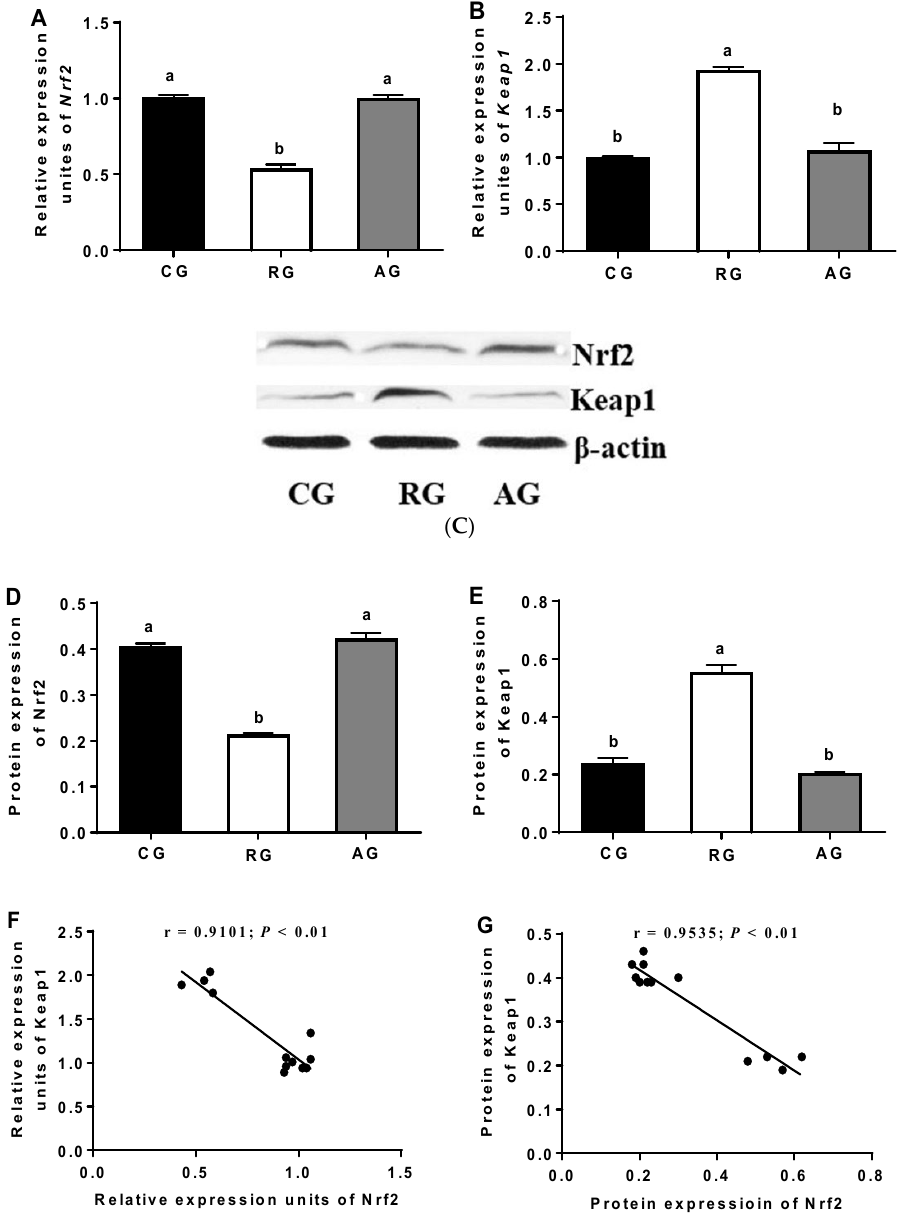
Figure 4. Effects of diet and arginine on Nrf2/Keap1 pathway in ovaries of ewes. ( A ): Relative expression units of Nrf2; ( B ): Relative expression units of Keap1; ( C ): The protein expressions of Nrf2 and Keap1 were determined by western blot; ( D ): Protein expression of Nrf2; ( E ): Protein expression